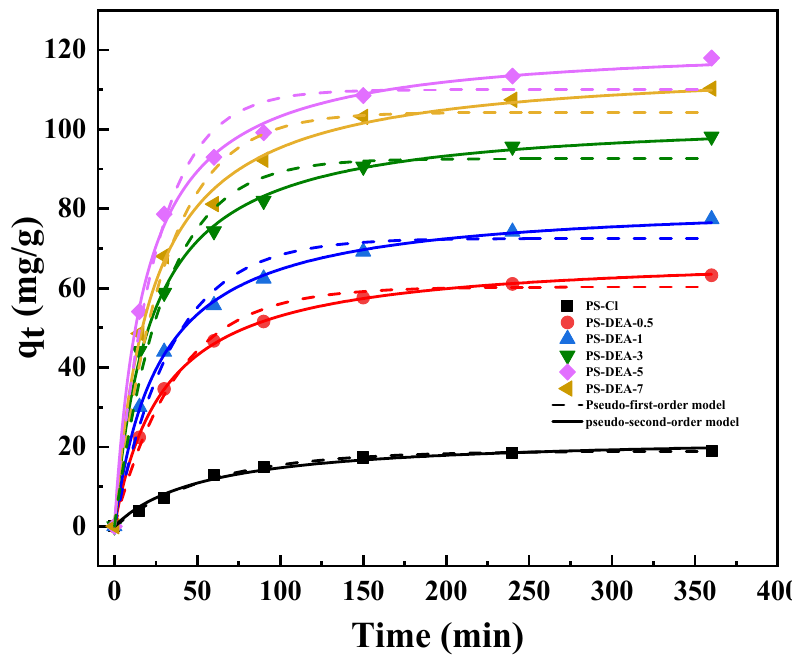
Figure 7. Adsorption kinetic fitting of pseudo − first − order and pseudo − second − order model on PS − DEA − x. Table 5. Adsorption kinetic parameters of pseudo − first − order and pseudo − second − order model on PS − DEA − x.